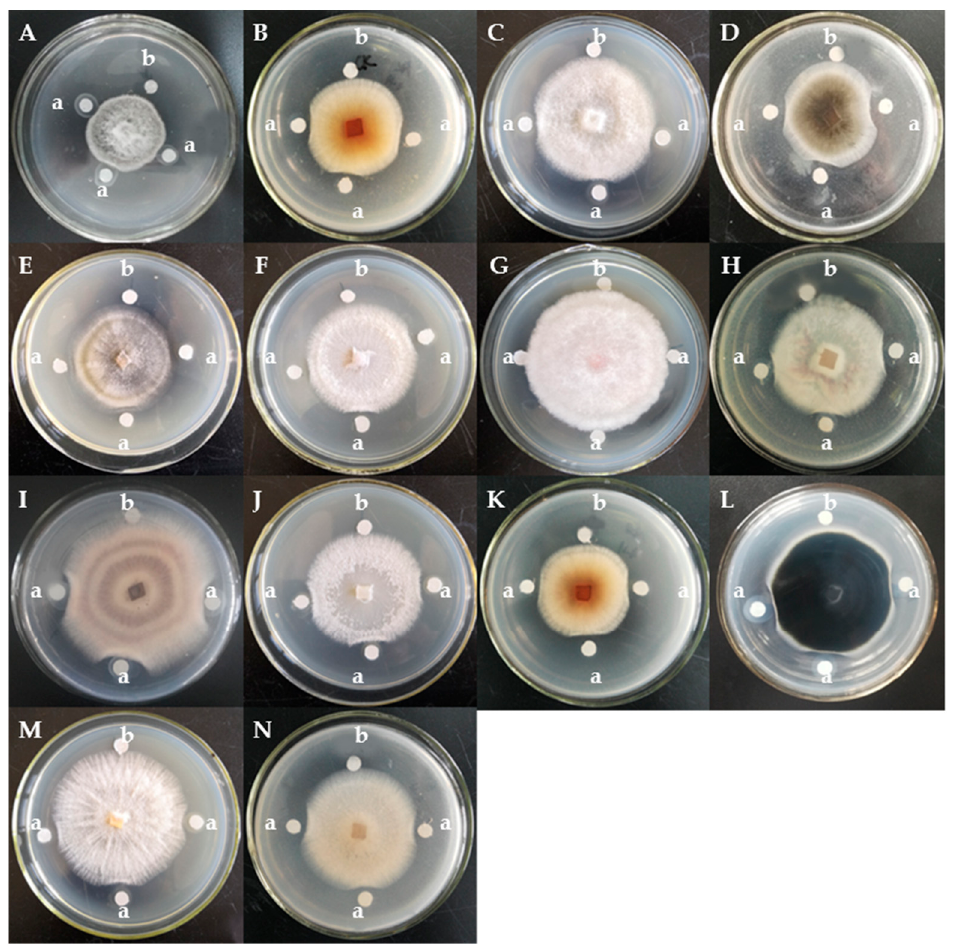
Figure 2. Growth inhibitory effects of BGAP represented by fraction SU3 toward 14 phytopathogenic fungi: ( A ) Alternaria longipes ; ( B ) Botrytis cinerea ; ( C ) Colletotrichum gloeosporioides ; ( D ) Colletotrichum higginsianum ;